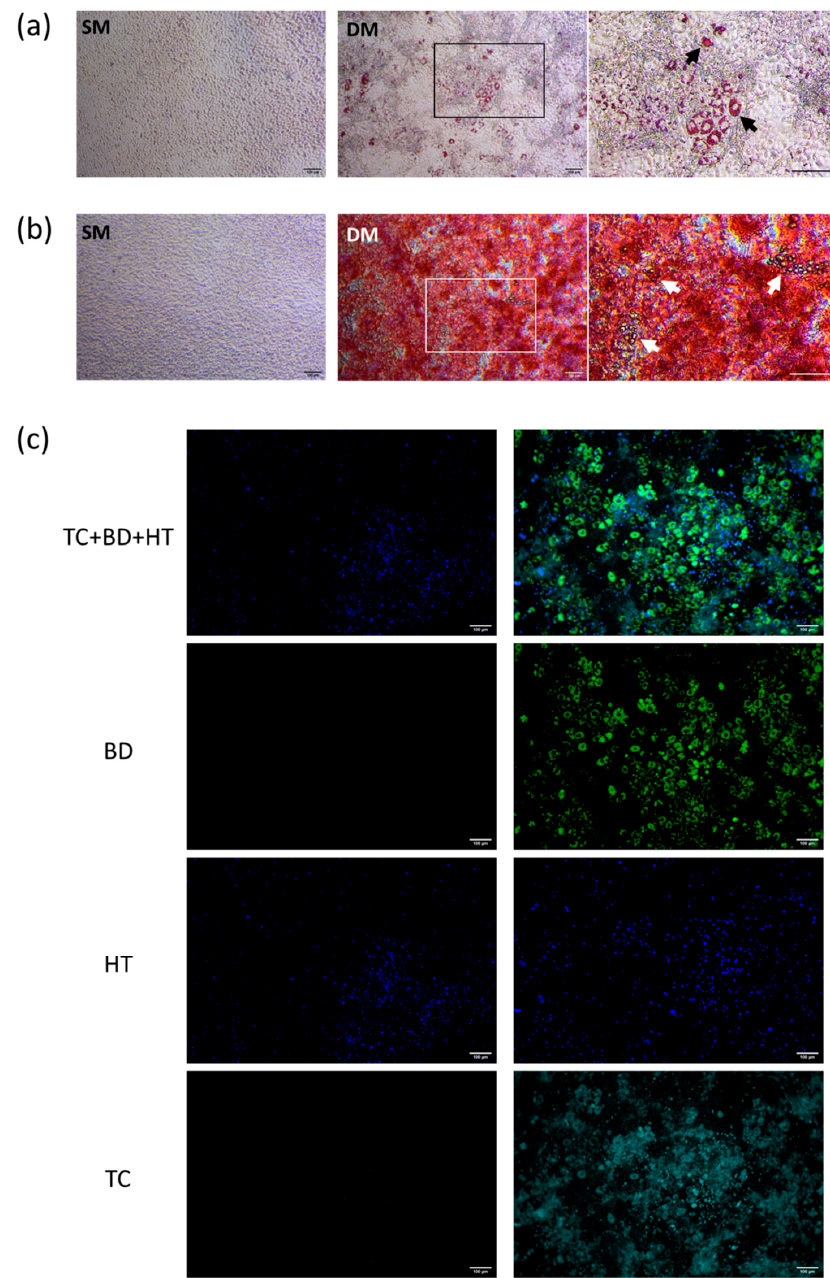
Figure 1. Imaging of MSC cultures under control and differentiating culture conditions. ( a , b ) Typical validation of dual MSC differentiation at the endpoint showing strong Oil Red O-positive lipids ( a ) and Alizarin Red-positive signal ( b ) under DM treatment, revealing adipocytes (arrows) embedded in the strongly mineralised matrix. Scale bar = 100 μ m ( c ) Fluorescence imaging of live MSCs after combined TC, BD and HT labelling at day 19 under undifferentiated (left panel) and differentiated (right panel) conditions, showing strong BD intensity (bright green) with diffuse TC signal (turquoise) with HT nuclear counterstain (blue). Representative images taken from two cultures stained in parallel. Scale bar = 100 μ m.